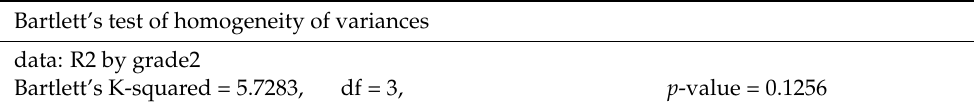
Table 8. Bartlett’s test for flexure strength for DETAX material.